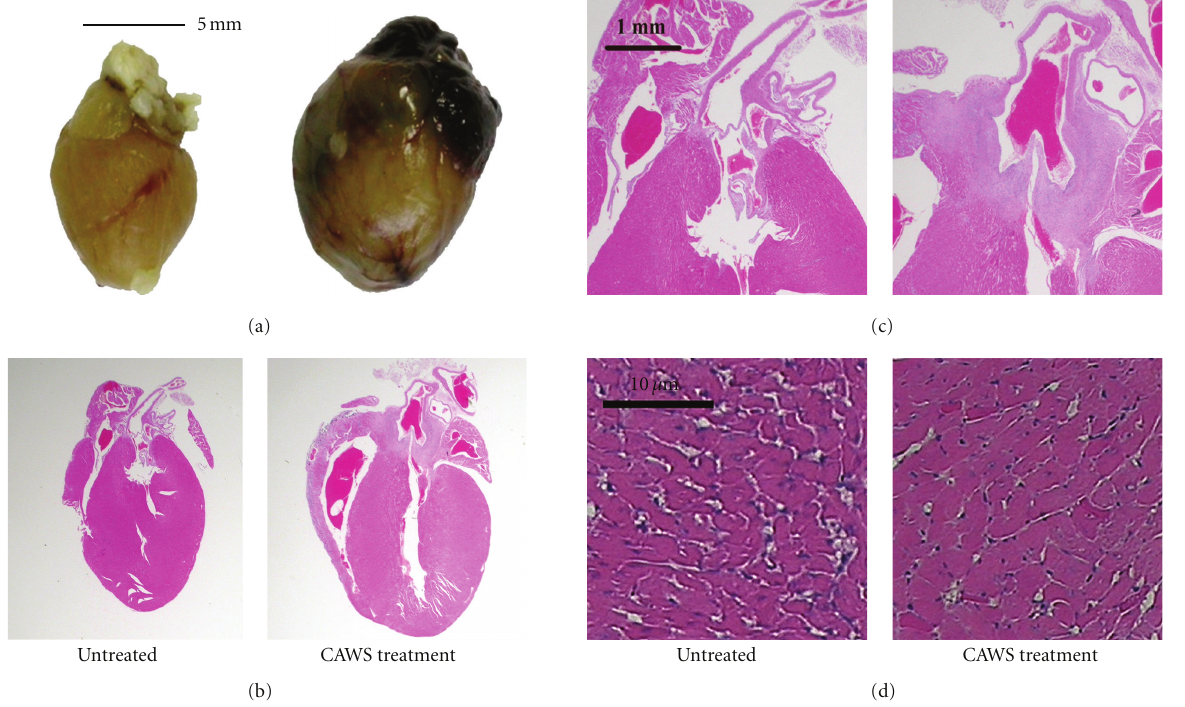
Figure 4: Cardiomegaly and histopathological changes of the aortic root due to CAWS arteritis. Macroscopic cardiomegaly and concentric left ventricular hypertrophy were observed in the CAWS treatment group (a, b). The panels (c) represent enlarged views of each aortic valve. Inflammatory cells were located mainly in the aortic valve and Valsalva sinus, and severe stenosis of the left ventricular outflow tract (LVOT) was found in CAWS arteritis. There was no evidence of necrosis or fibrosis to indicate broad infarctions in the left ventricular wall. The cross sectional area of CAWS-treated cardiomyocyte was increased by 1.14 fold (d).